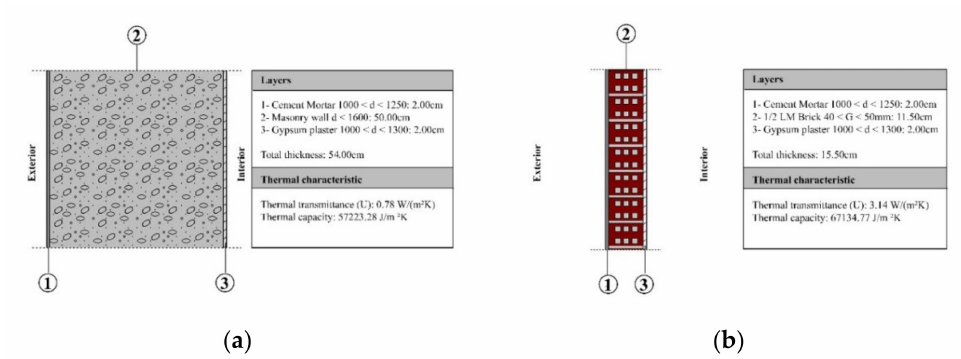
Figure 4. ( a ) Construction system based on masonry walls installed on the ground floor; ( b ) construc- tion system based on a simple brickwork layer installed on the first and second floors.